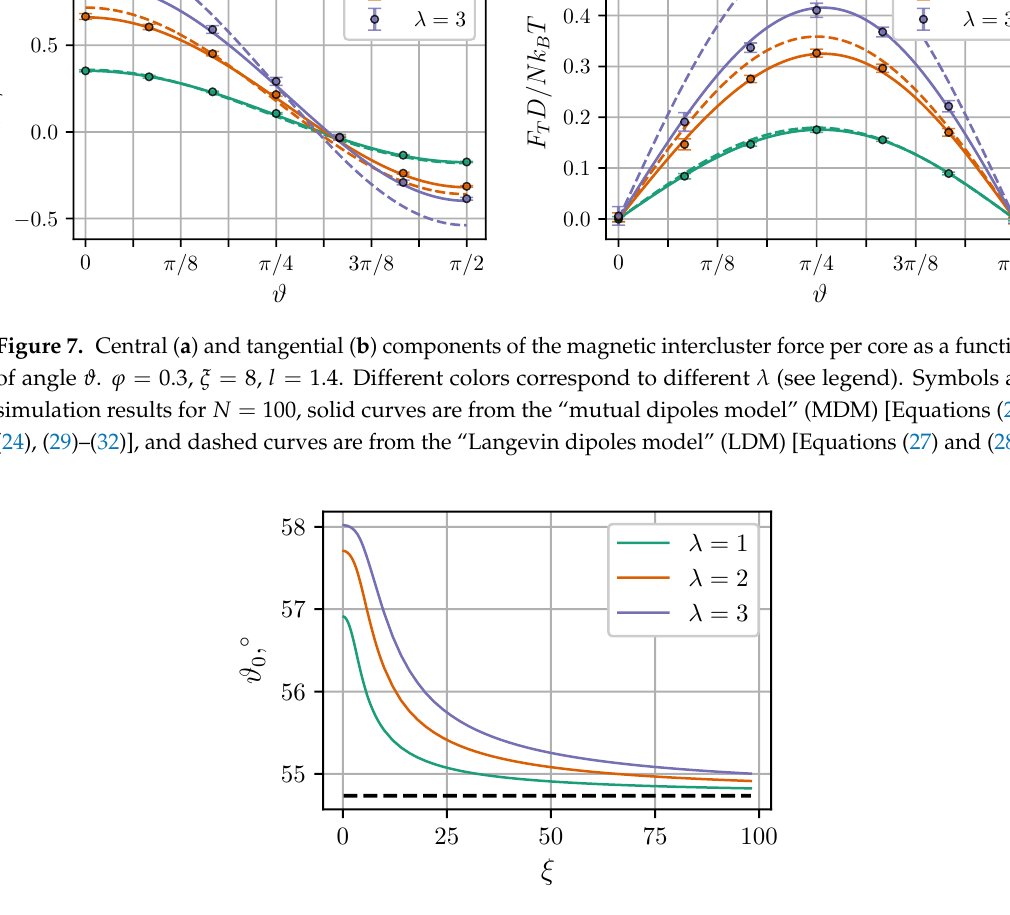
Figure 8. Critical angle ϑ 0 at which the central force changes sign as a function of the applied field ξ . Solid curves are MDM predictions for ϕ = 0.3, l = 1.4 and different λ (see legend). The dashed horizontal line is the classical LDM value ϑ 0 = arccos ( 1/ √ 3 ) 54.7 ◦ (cid:39)